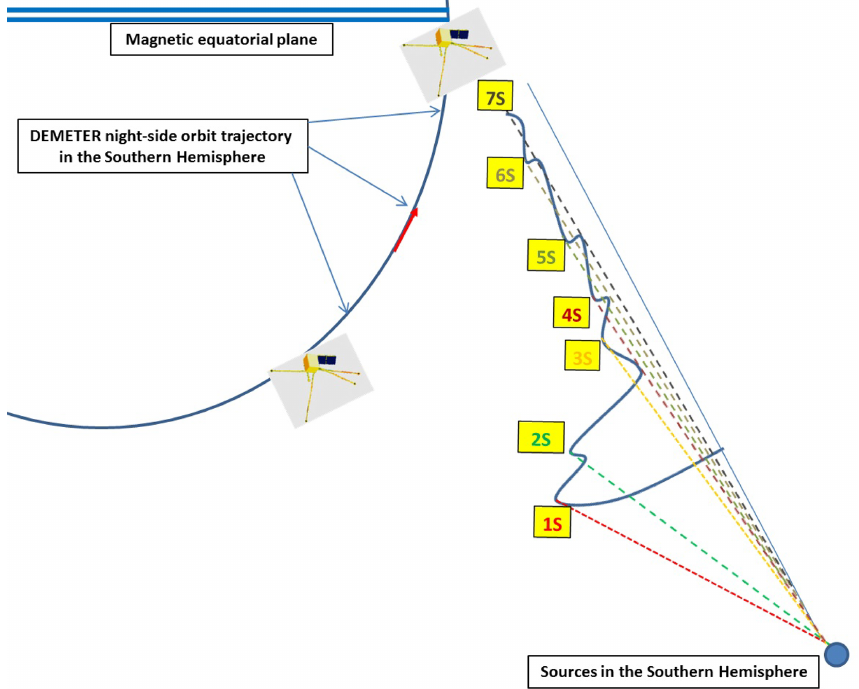
Figure 7. Sketch of the beams observed in the Southern Hemisphere for specific magnetic latitudes and frequencies (i.e. 1S, 2S, 3S, 4S, 5S, 6S and 7S) as listed in Table